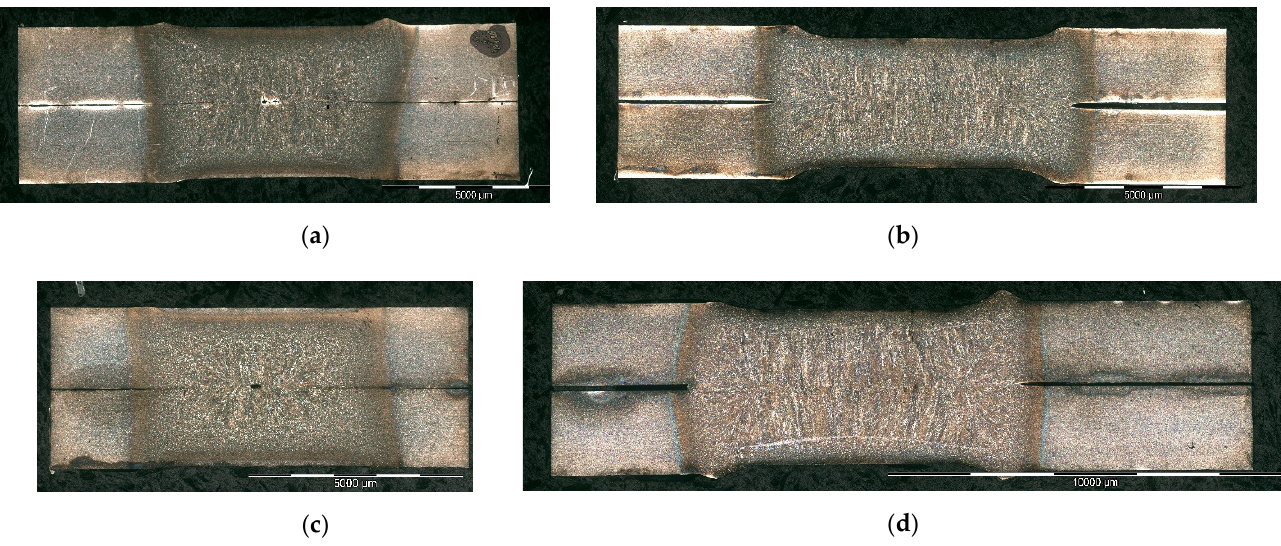
Figure 5. Macrography for f = 1000 Hz: ( a ) D min for f = 1 kHz; ( b ) D Proy for f = 1 kHz; ( c ) D min for f = 7. kHz; ( d ) D Proy for f = 7 kHz.